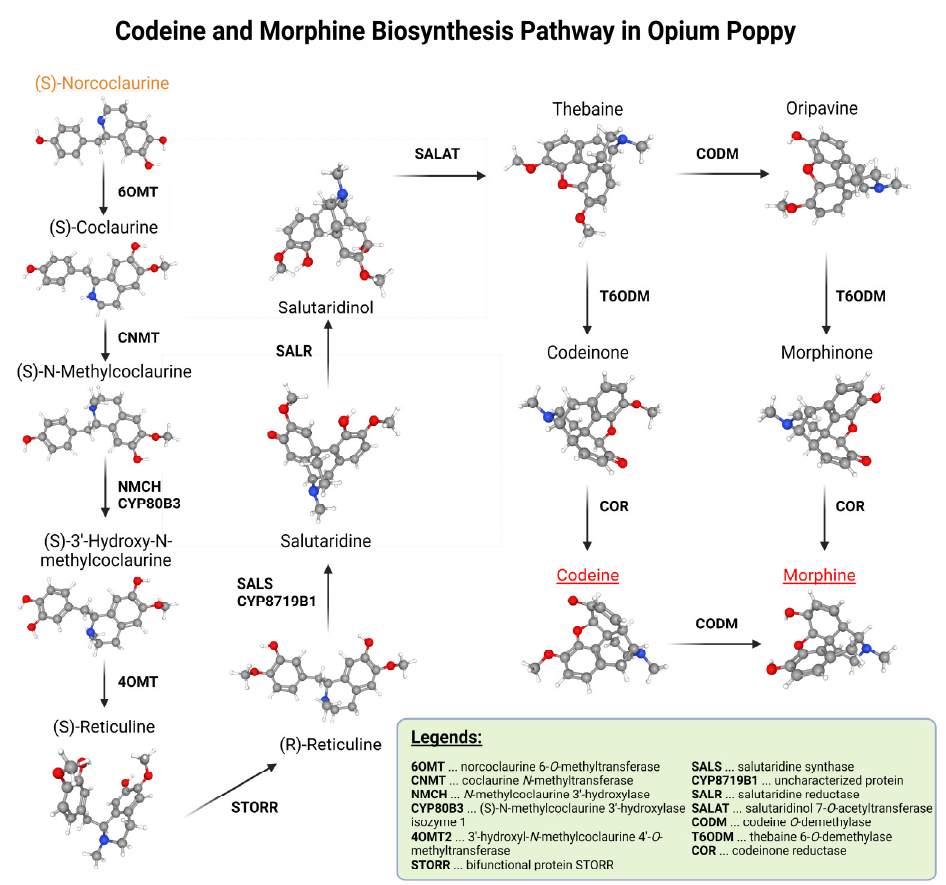
Figure 1. Morphine biosynthesis pathway without branches leading to different stable alkaloids. Three selected genes were amplified by PCR to the maximum possible length. Amplicons were barcoded using SMRTbell 96 barcoded adapter plate 2.0 and sequenced using PacBio SEQUEL-SMRTII chemistry. Out of the 96 sequenced and possibly mutant plants, mutations were found in 6 of them. Mutation identification was carried out in the leaves